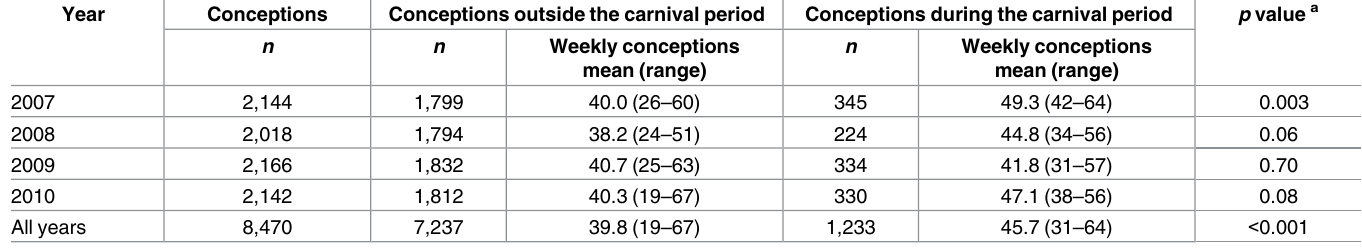
Table 2. Weekly number of conceptions occurring during and outside the carnival period, from January 1 2007 to December31 2010 recorded at the University Hospital in Guadeloupe (French West Indies).